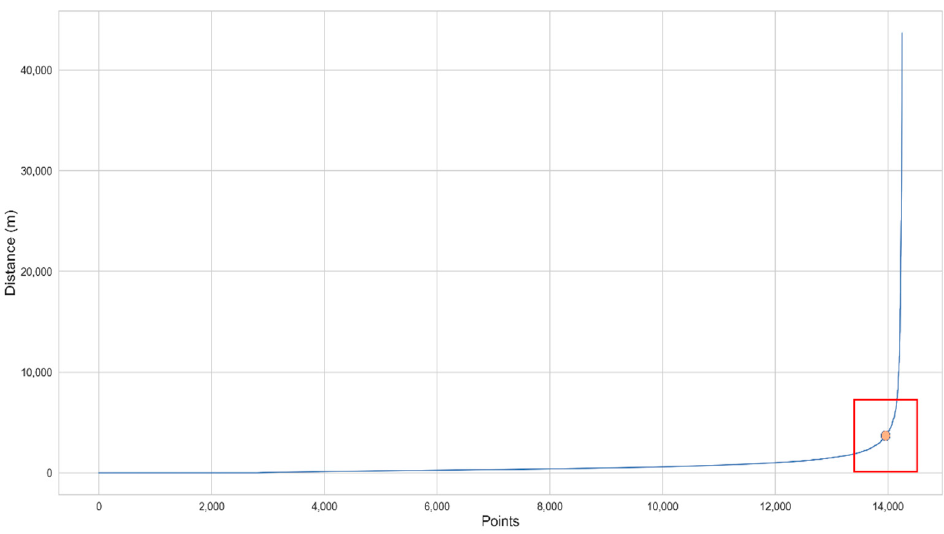
Figure 4. Example of the k-distance graph, which shows the distances between each point and its k nearest neighbors. An elbow point is shown in orange, and a red box describes the possible selection range of the elbow point.